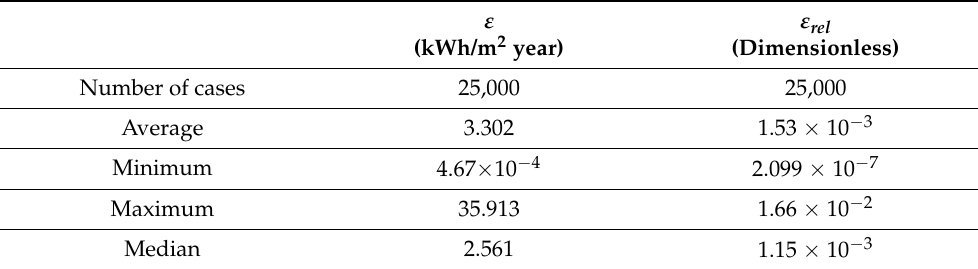
Table 4. Synoptics of the errors ε Equation (30) and ε rel Equation (31) obtained for the model given by Equation